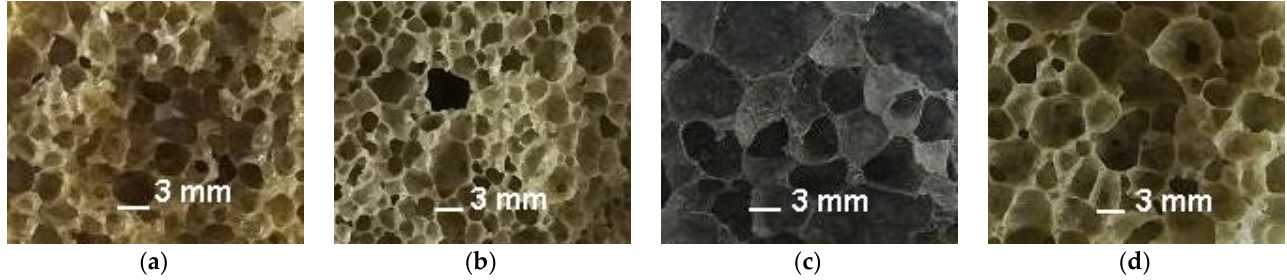
Figure 9. The structure of expanded glass mass granules: ( a ) without additives; ( b ) with opoka; ( c ) with WMS; ( d ) with lignite clay.